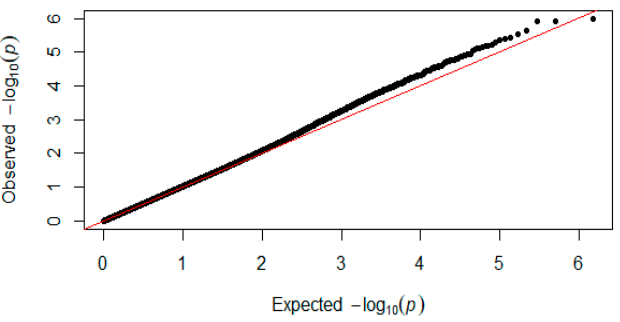
Figure 3. Quantile–quantile plots of p -values for muscle glycogen. The x-axis is the expected − log 10 p -value and the y-axis is the observed − log 10 p -value.